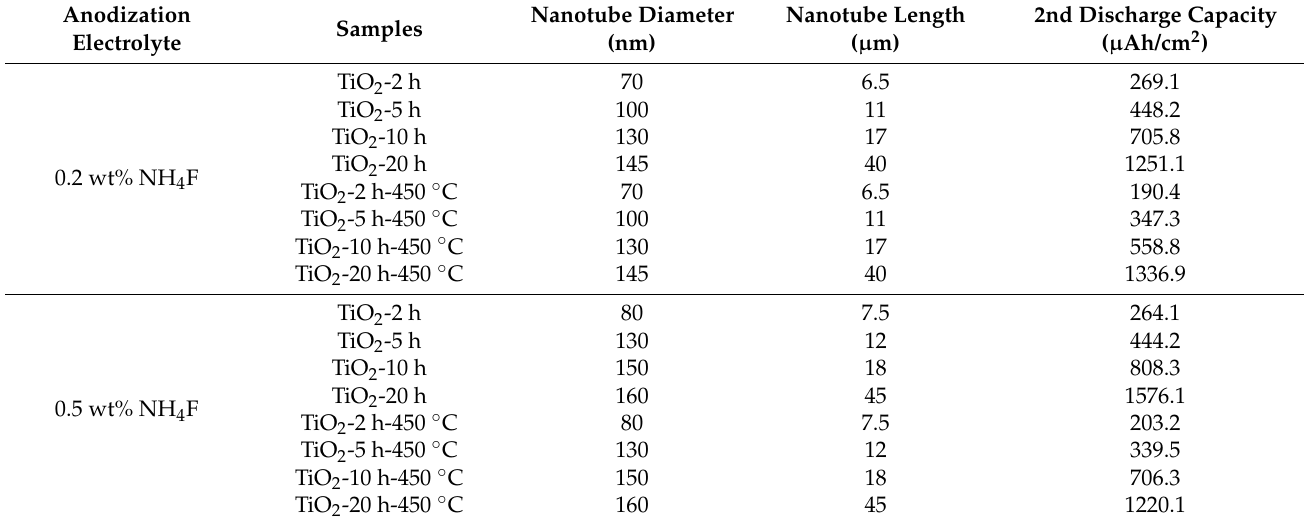
Table 1. Relationship between the second discharge capacity and the diameter/length of the nanotubes. Anodization